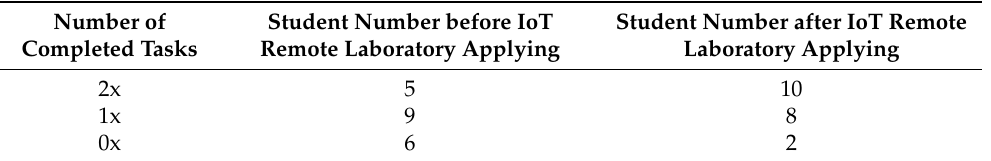
Table 3. The average success of solving problems before and after the application of the IoT re- mote